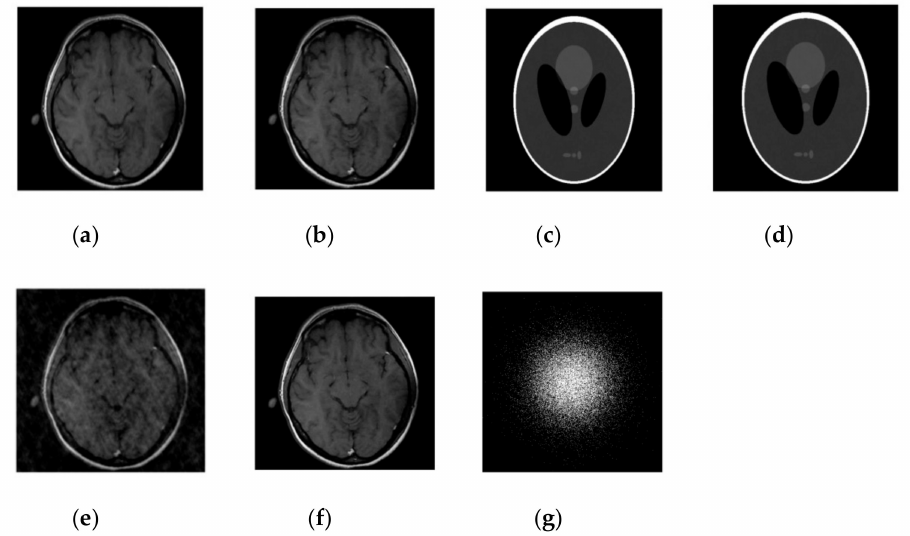
Figure 2. Images recovery for noiseless case. ( a ) Recovered MR image of brain by SiFo; ( b ) Recovered MR image of brain by DLMRI; ( c ) Recovered MR image of phantom by SiFo; ( d ) Recovered MR image of phantom by DLMRI; ( e ) Reconstruction brain image with zero filling; ( f ) Reference MR image for brain; ( g ) k -space sampling mask with 10